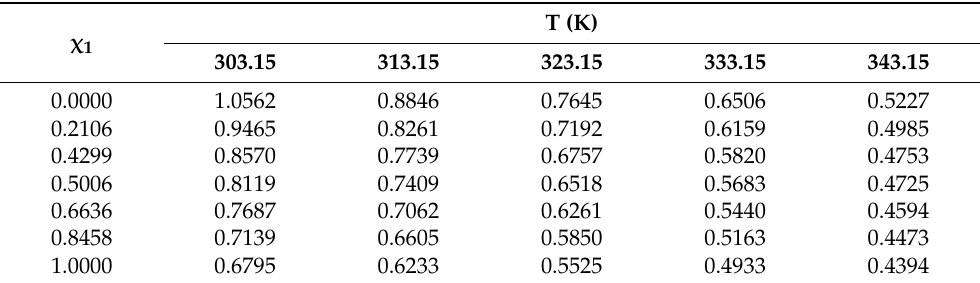
Table 6. The absorption quantities of NO 2 by {[EMIM] [TFA] ( χ 1 ) + TEA (1 − χ 1 )} binary systems at